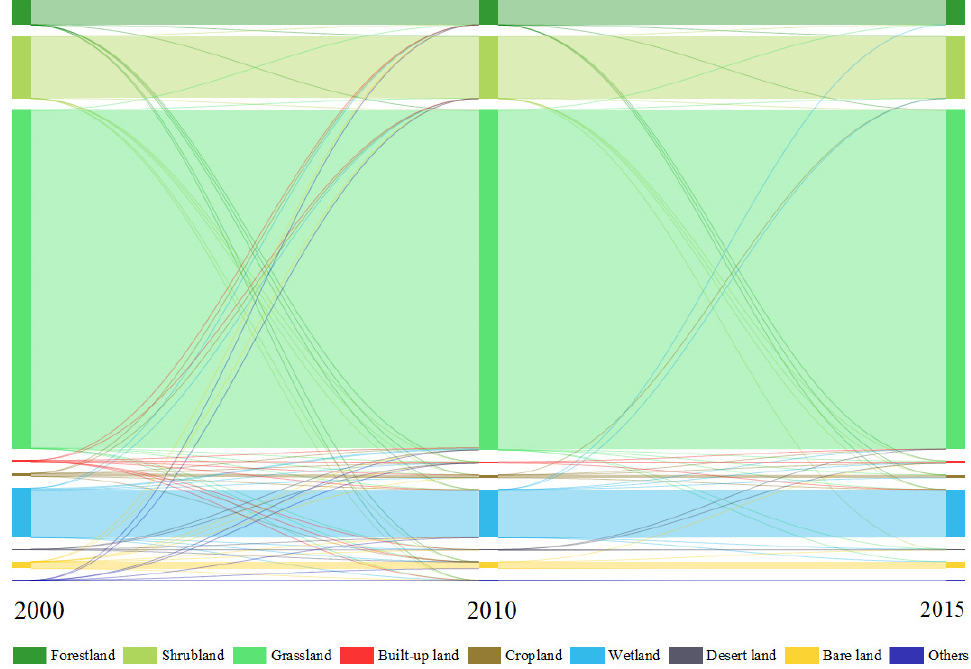
Figure 3. Land use composition and transformation from 2000 to 2015.